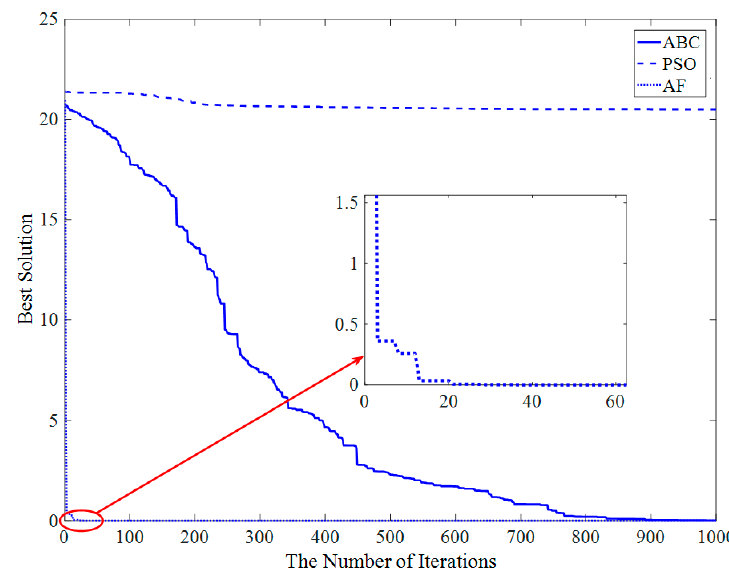
Figure 14. The convergence curve of the three algorithms for Ackley function in 50-dimensional space.